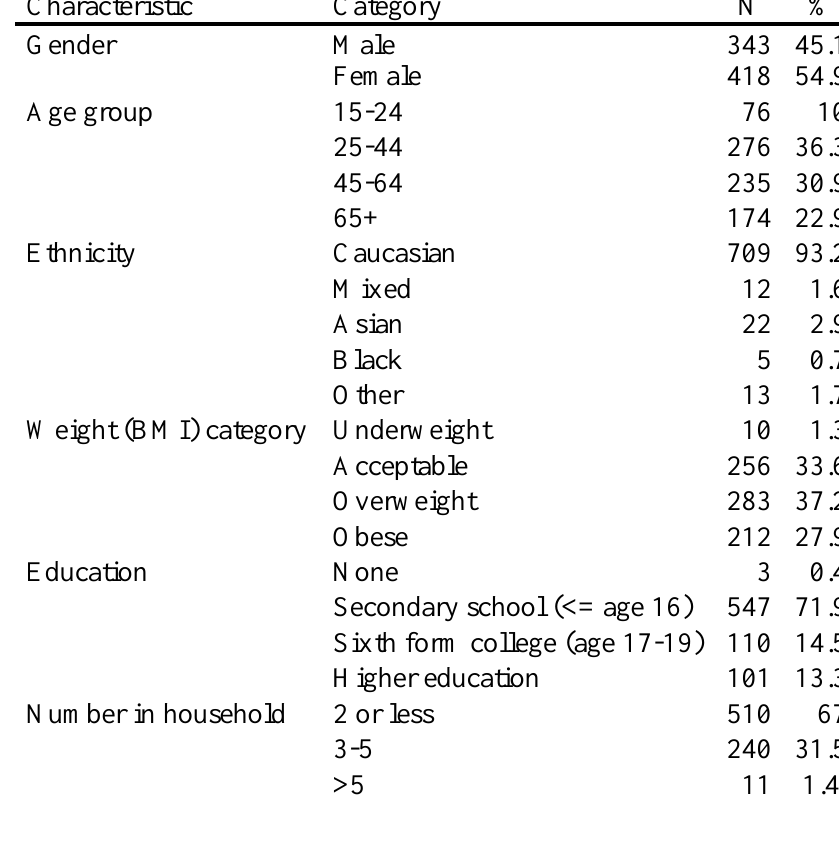
Table 1. Demographic characteristics of the